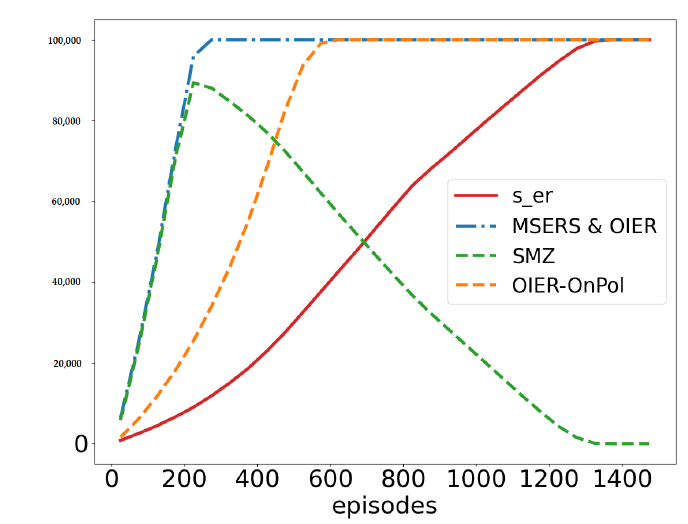
Figure 8. The intuition of Interpolated Experience Replay memory for the VE state encoding and t expl = 500.